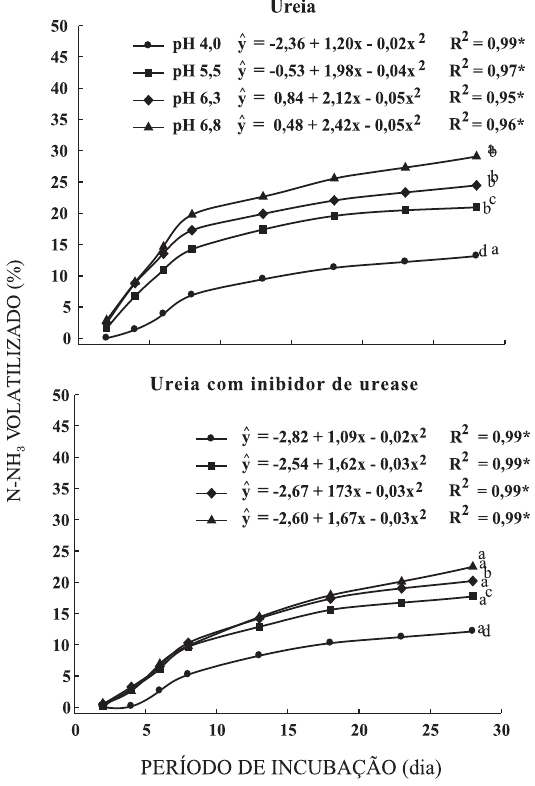
Figura 4. Volatilização acumulada de NH do solo ao 3 longo do tempo a partir da aplicação de 100 kg ha -1 de N na forma de ureia convencional ou de ureia com inibidor de urease, mantido na temperatura ambiente de 18 o C. Letras diferentes representam diferença estatística (p < 0,05) entre as fontes para o mesmo pH, pelo teste de Tukey. * Significativo (p <